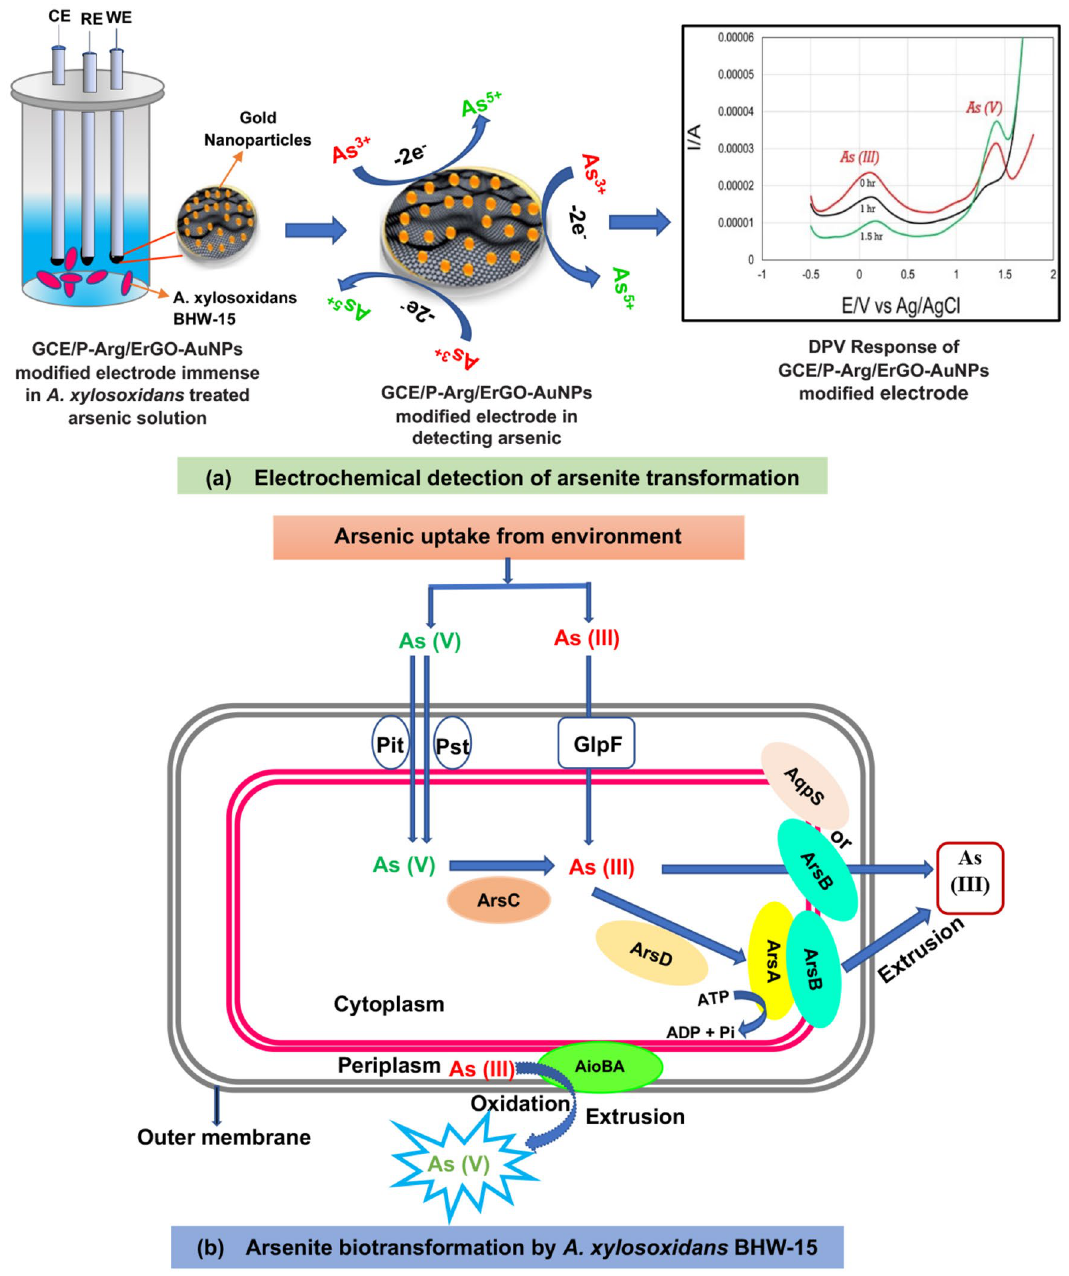
Figure 7. Electrochemical detection and molecular mechanism of A. xylosoxidans mediated As (III) biotransformation. ( a ) Electrochemical detection of arsenic transformation: GCE/P-Arg/ErGO-AuNP modified electrodes were placed in As solution treated with A. xylosoxidans BHW-15. In this experiment, a modified three-electrode (CE: Counter electrode, RE: Reference electrode, WE: Working electrode which was modified with gold (Au) nanoparticle) based system was used to measure the differential pulse voltammetry. The Differential Pulse voltammetry (DPV) response of arsenic on the surface of the electrode showed a remarkable peak current during the oxidation of As (III) to As (V) by the strain at a scan rate of 50 mVs −1 . ( b ) Proposed model of As (III) biotransformation by A. Xylosoxidans BHW15: The bacterium uptake arsenic from the environment in different forms utilize it as an electron donor and energy source in their cell. The genome of BHW-15 carried two operons—aioSXBA (oxidation) and arsRCAD (reduction). Cytoplasmic reduction of As (V) to As (III) is occurred by the ArsC protein leading to subsequent extrusion via ArsB or ArsAB pump is pumped out from the cell by efflux pump specific ArsB transporter while, aio operon regulates the oxidation of the arsenite to arsenate inside the cell in presence of periplasmic arsenite oxidase (aioBA) enzyme and pumps it out form the cell using unknown efflux pump (Istiaq et al. 26 ). We found the oxidation process of As (III) to As (V) by A. xylosoxidans BHW-15 was